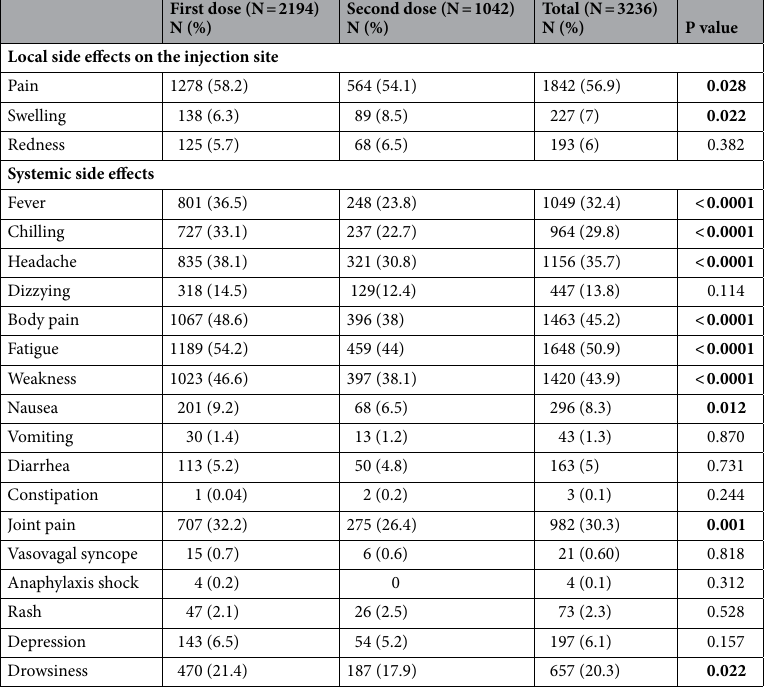
Table 2. The side effects of Sputnik V COVID-19 vaccine after first and second dose. P value < 0.05 showed by